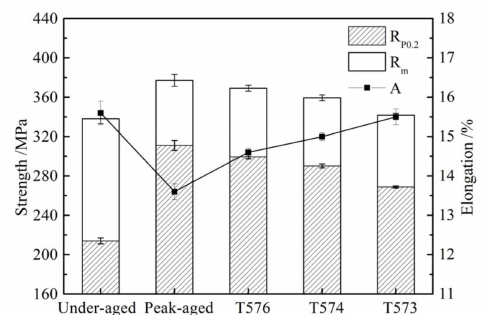
Figure 7. Tensile properties for the di ff erent aged alloys at room temperature.